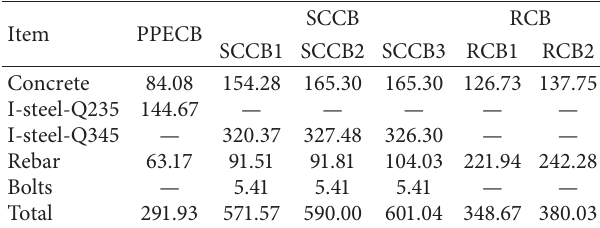
2 emission of different beams.